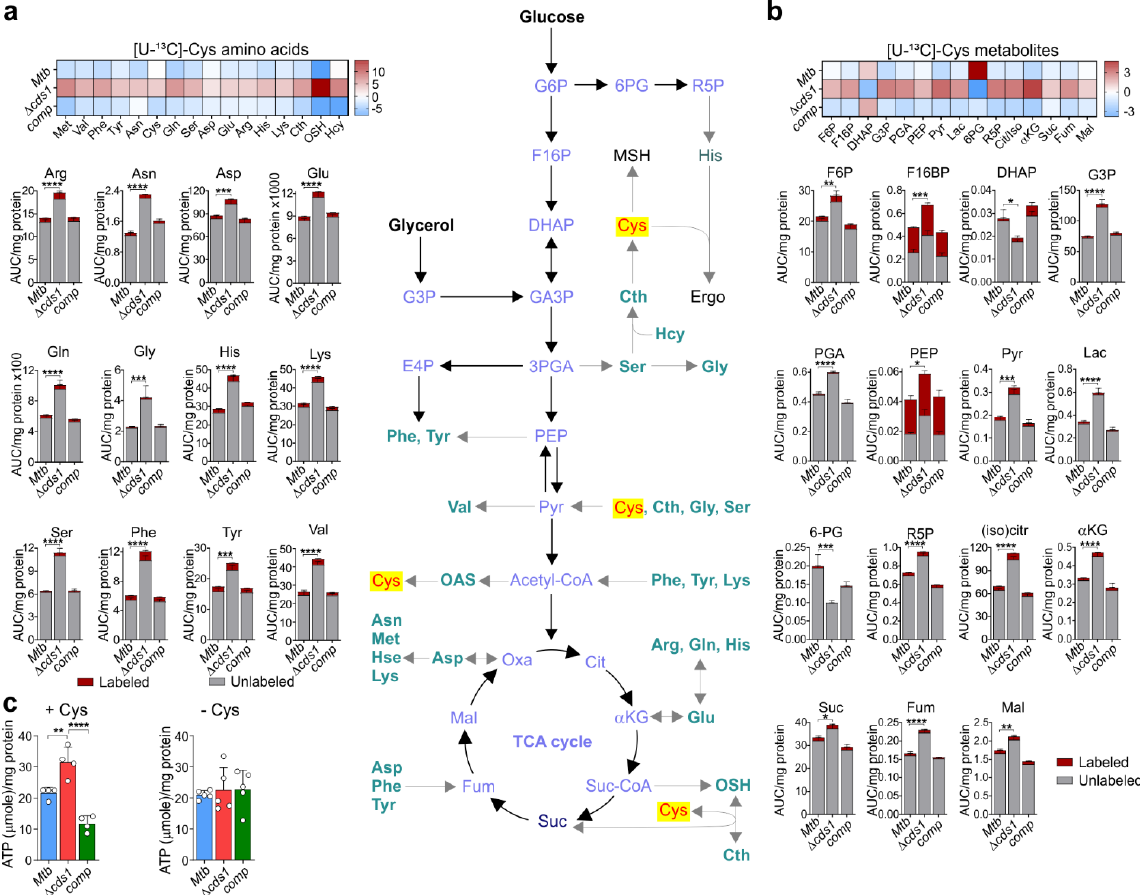
Figure 7. Cds1 regulates central metabolism in Mtb . Cds1 in Mtb regulates amino acids (turquoise), Cys (red), and glycolysis and TCA cycle metabolites (blue). LC-MS/MS analysis of ( a ) amino acids, ( b ) glycolysis, the pentose phosphate pathway, and the TCA cycle metabolites is indicated by heat maps (top) and total abundance. Mtb strains were cultured in 7H9 medium with [U- 13 C]-Cys (100 µM). ( c ) ATP levels measured in Mtb strains with (+) and without (−) 100 mM Cys. Representative experiments are shown; each experiment was repeated at least twice. Data represent the mean ± SEM for n = 3–5 biological replicates. Statistical analysis was performed using GraphPad Prism 8.4.3. Two-way ANOVA ( a , b ) or one-way ANOVA ( c ), Dunnett’s multiple comparisons test were used to determine statistical significance. * p < 0.05, ** p < 0.01, *** p < 0.001, **** p <